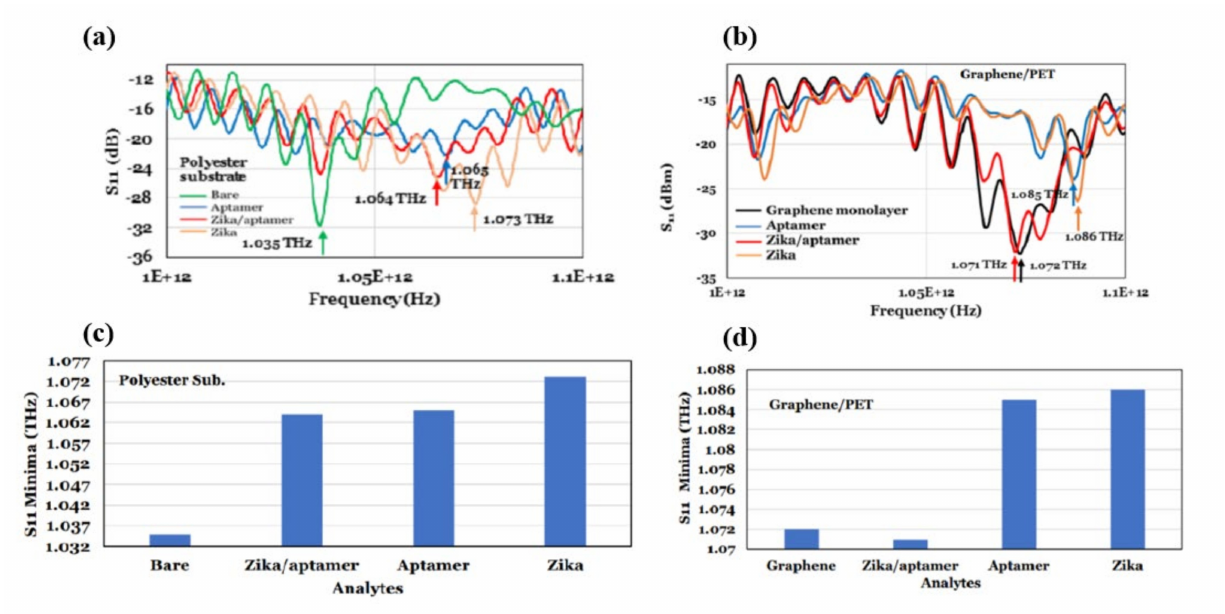
Figure 13. ( a ) Terahertz reflection (S11) properties of aptamer, aptamer/Zika, and Zika on polyester substrate. ( b ) Reflection spectra minima of different materials on polyester substrate. ( c ) Terahertz reflection coefficient of different aptamer and Zika on graphene. ( d ) Terahertz reflection minima for different analytes on graphene. Reprinted with permission from